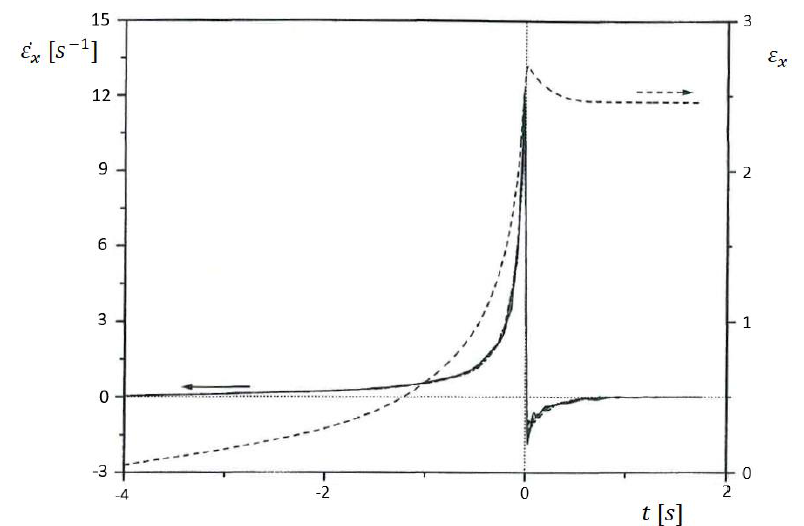
Figure 10. Elongational rate 𝜀 𝑥 ̇ and total elongation 𝜀 𝑥 along the channel axis a function of time for a commercial LDPE extruded through a slit die with a reservoir of 14 mm squared and a capillary with a height of 1 mm and a width of 14 mm at 150 °C and an apparent shear rate of 𝐷 = 100 s −1 [24]. The time was set to zero at the slit entrance.